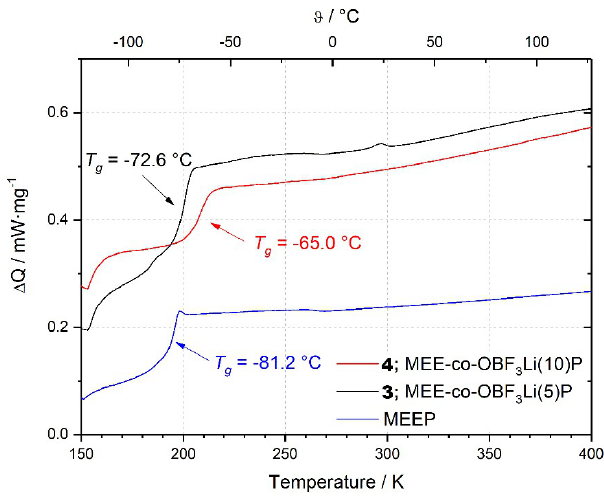
Figure 3. DSC Measurements of MEEP, MEE- co -OBF 3 Li(5)P, and MEE- co -OBF 3 Li(10)P.